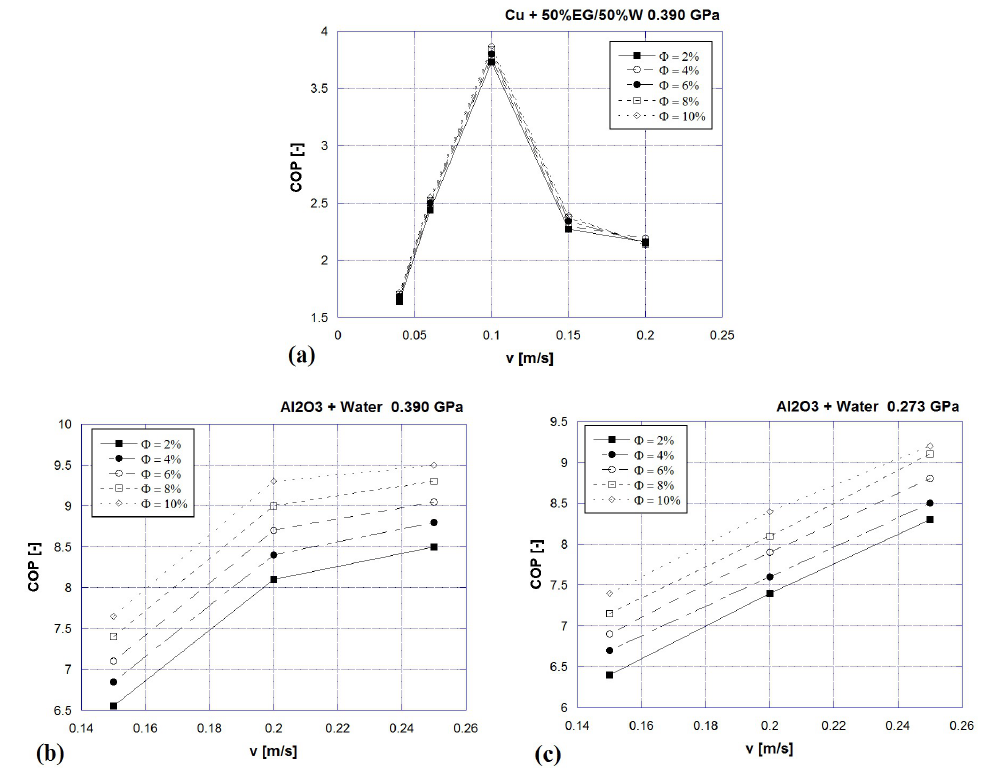
Figure 4. Coe ffi cients of performance detected in: ( a ) cooling mode ∆ p = 0.390 GPa; heat pumping Figure 4. Coefficients of performance detected in: ( a ) cooling mode ∆p = 0.390 GPa; heat pumping mode ( b ) ∆ p = 0.390 GPa and ( c ) ∆ p = 0.273 GPa when the system employs nanofluids as mode ( b ) ∆p = 0.390 GPa and ( c ) ∆p = 0.273 GPa when the system employs nanofluids as HTF.